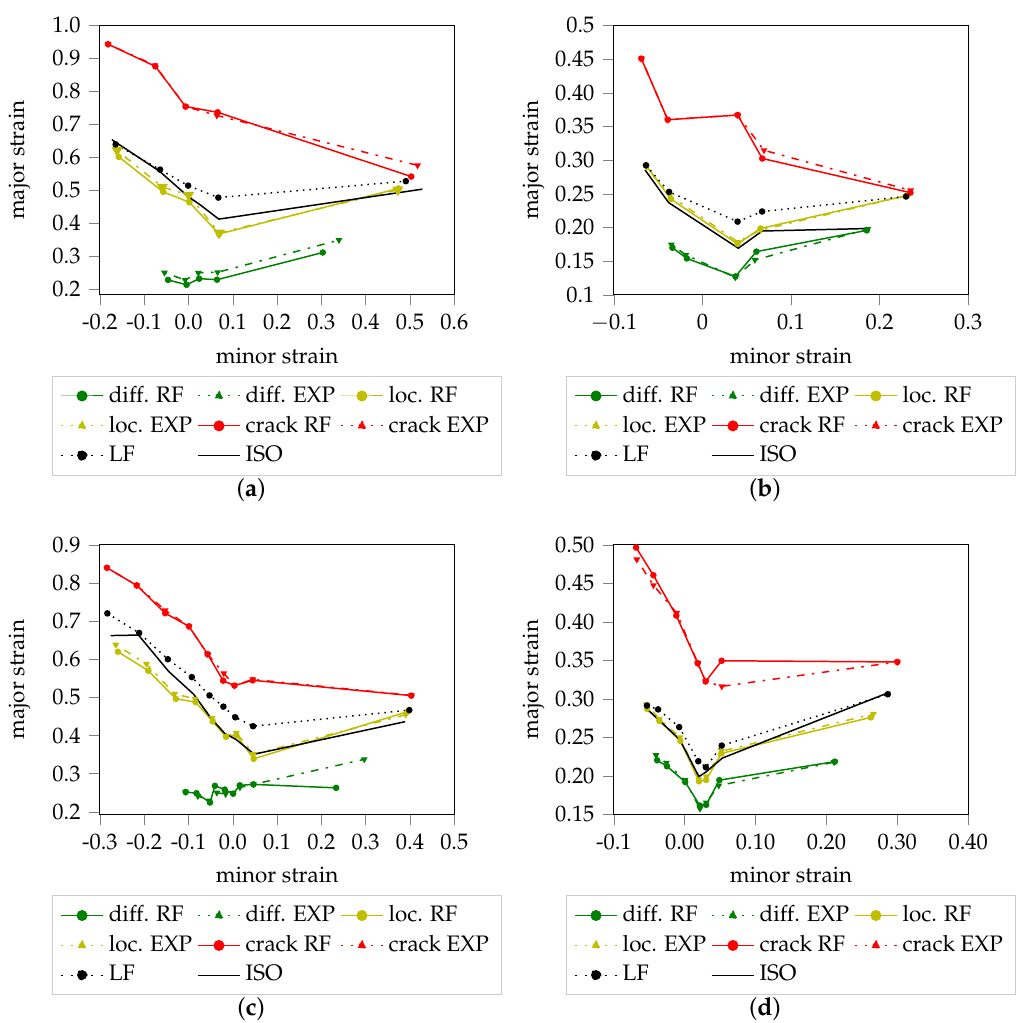
Figure 14. Comparison between expert annotations and machine learning algorithm using all geometries: ( a ) DX54D (2.00 mm). ( b ) DP800. ( c ) DX54D (0.75 mm). ( d )